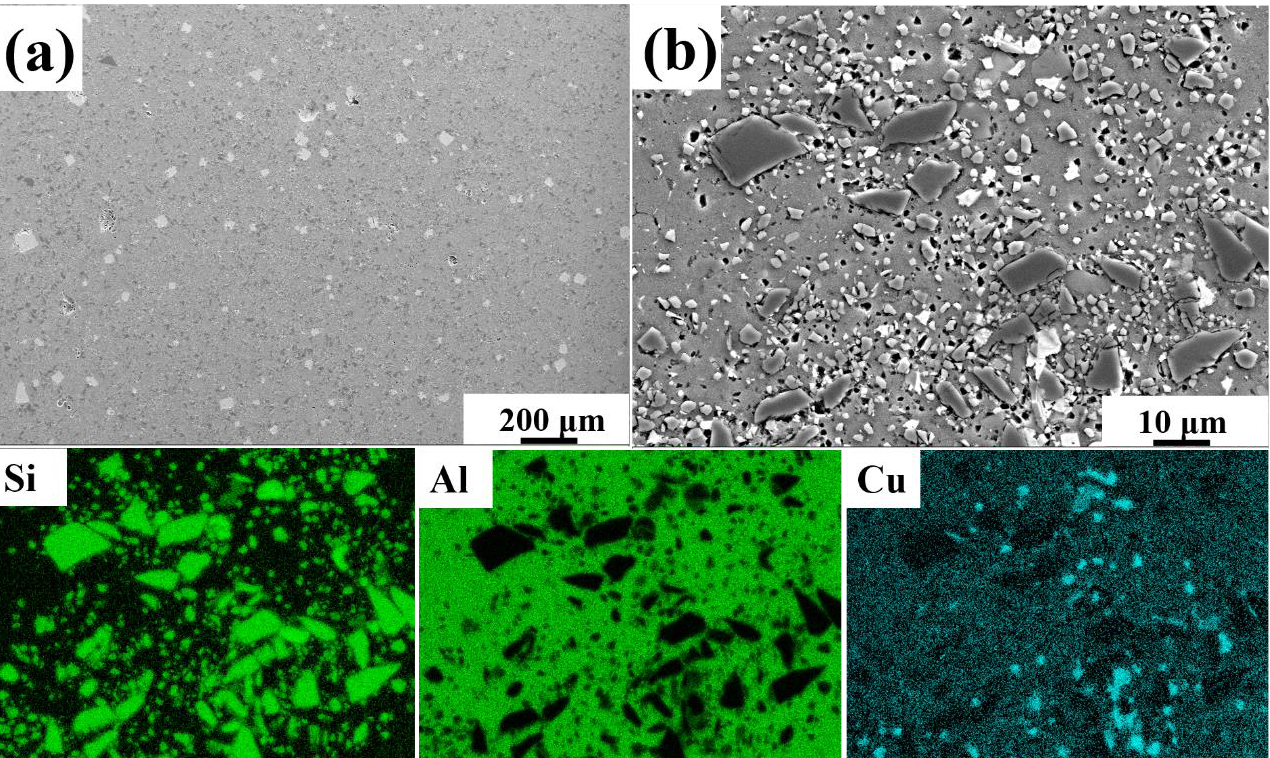
Figure 1. SEM images of 20 vol%SiC/2A14 base material and corresponding surface elements distribution mapping. ( a ) SEM image of base material with low magnification; ( b ) SEM image of characteristic region of base material.